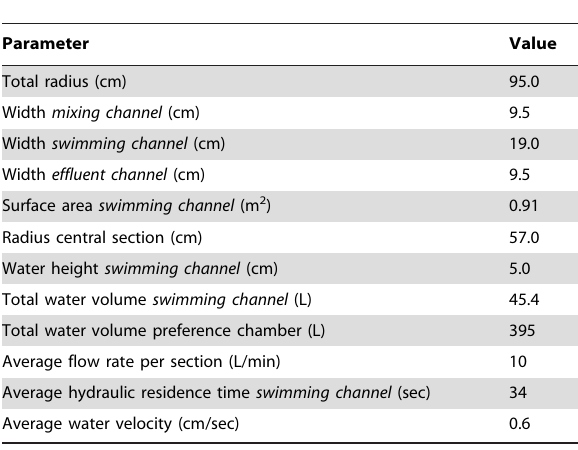
Table 1. Dimensions and settings of the preference